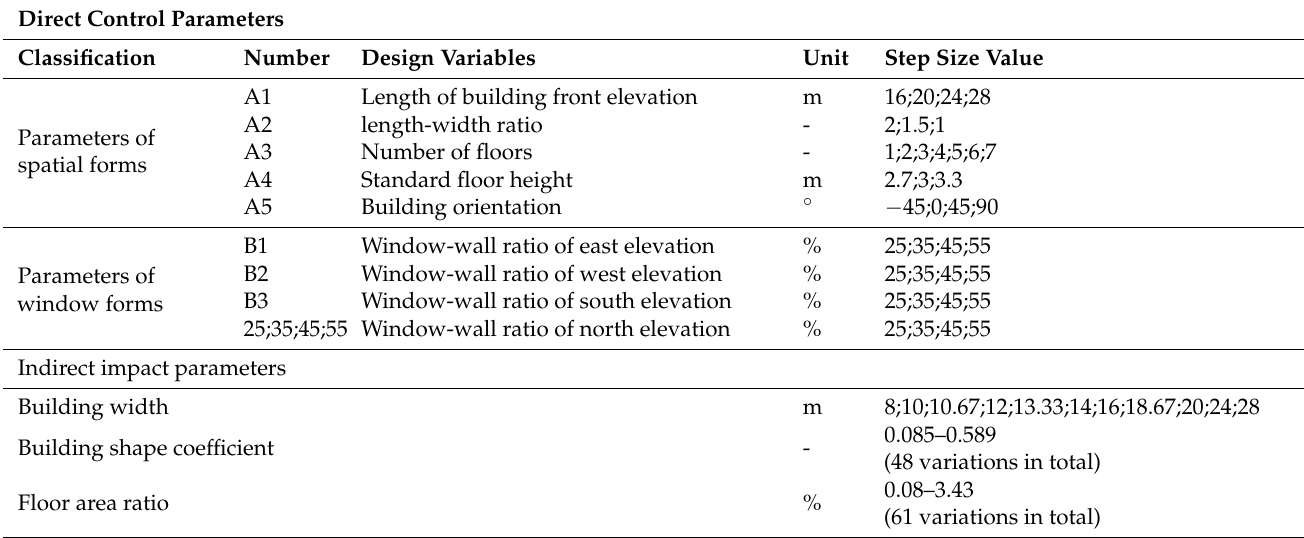
Table 5. Setting for optimal design parameters of building